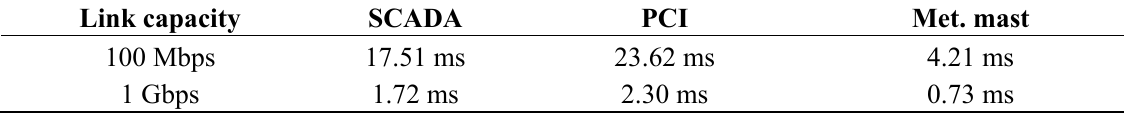
Table 10. Average ETE delay for medium-scale WPF.